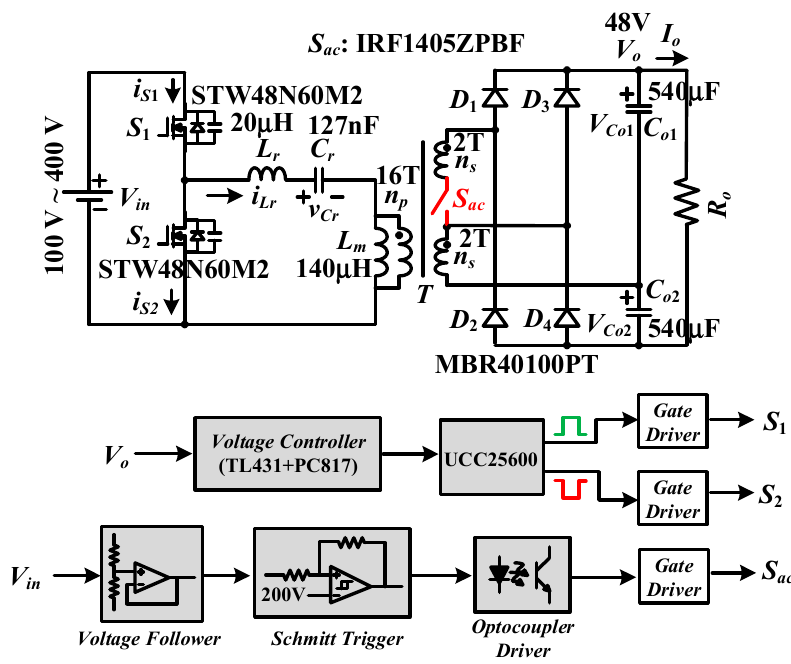
Figure 6. Circuit diagram of the laboratory prototype.